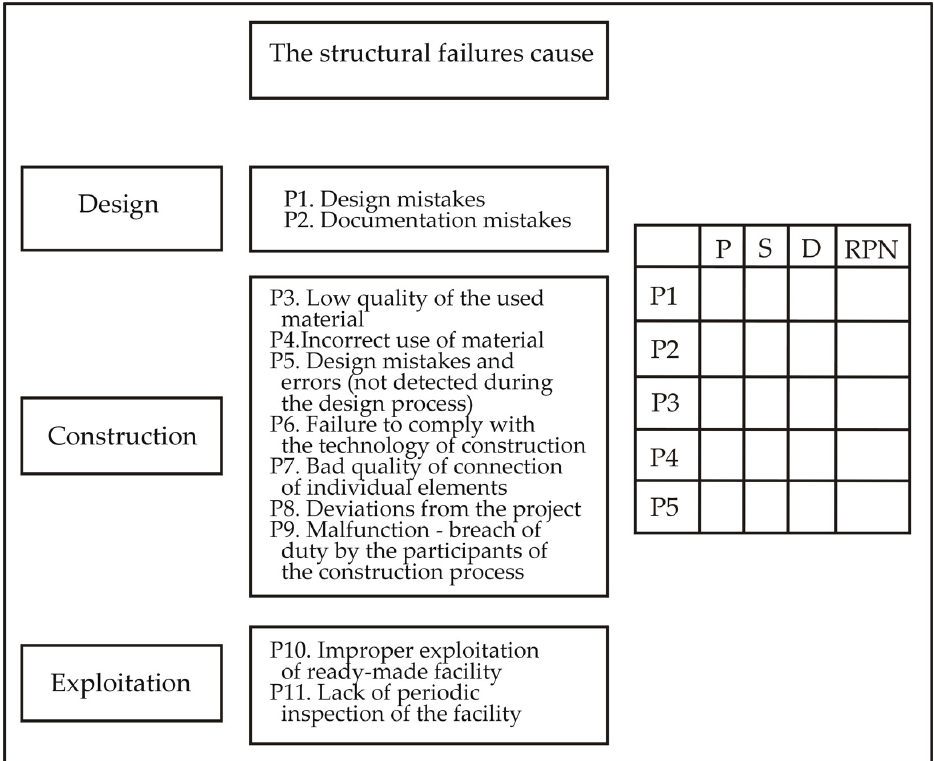
Figure 3. FMEA in structural failures analysis (own